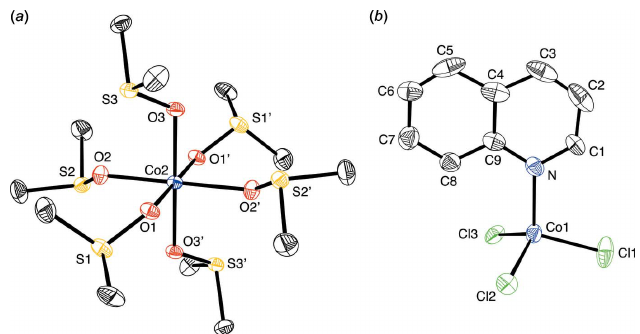
Figure 1 The molecular structure of the complex salt [Co II (Me 2 SO) 6 ][Co II Cl 3 qui- noline] 2 , showing ( a ) the [Co II (Me 2 SO) 6 ] 2+ cation (primed labels are related by the symmetry code: (cid:2) x , (cid:2) y , (cid:2) z + 2), and ( b ) the symmetry- unique [Co II Cl 3 quinoline] (cid:2) anion.